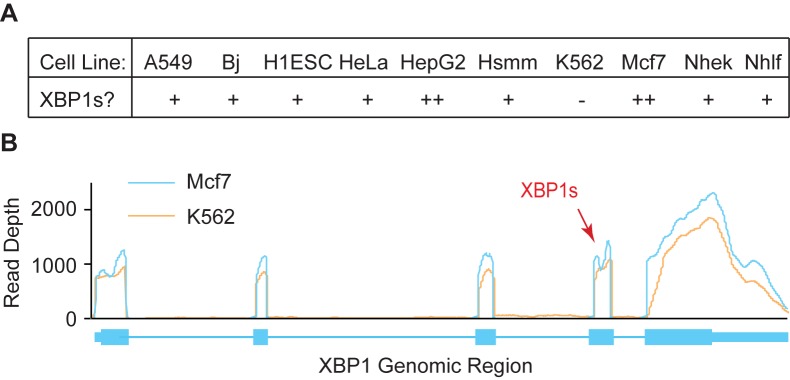
Summary of RNA-Seq analysis for the XBP1s intron.(A) Summarized are whether sequencing reads predicted the XBP1s intron in the cell lines listed. Sequence support was obtained in no (-), one (+), or two (++) samples as indicated. (B) For the Mcf7 and K562 cell lines, the sequencing read depth is plotted for the XBP1 locus. The region where the XBP1 mRNA short intron is found is indicated (XBP1s). Note the dip in sequencing read depth in this region only in the Mcf7 cell line, indicating some XBP1s splicing.